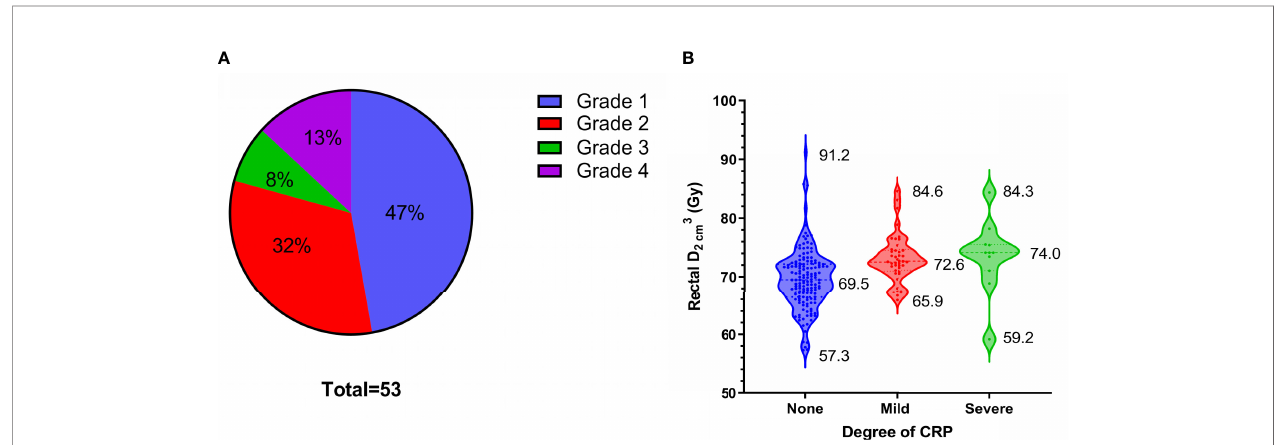
FIGURE 4 | 53 patients of chronic radiation proctitis (CRP). (A) The proportion of each grade of CRP. (B) Rectal D 2 cm 3 grouped by degree of